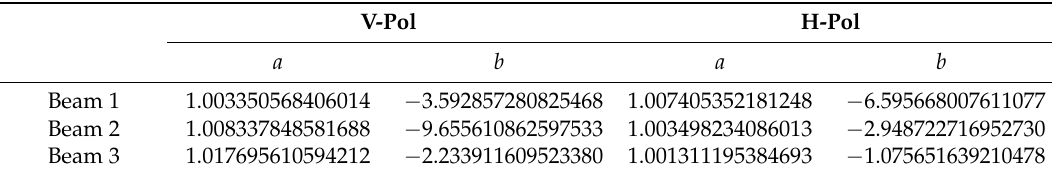
Table 1. Values for the coefficients (a, b).